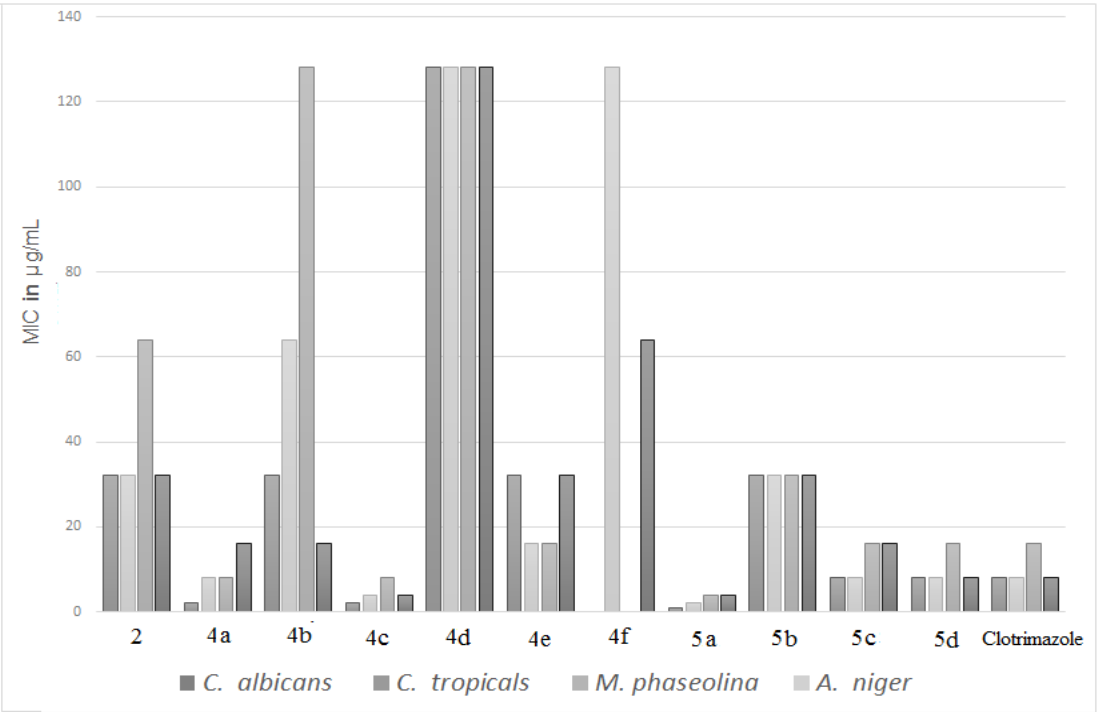
Figure 3. The antifungal activity (MIC in μg/mL) of the synthesized quinazolin-4(3 H )one derivatives compared with Clotrimazole .